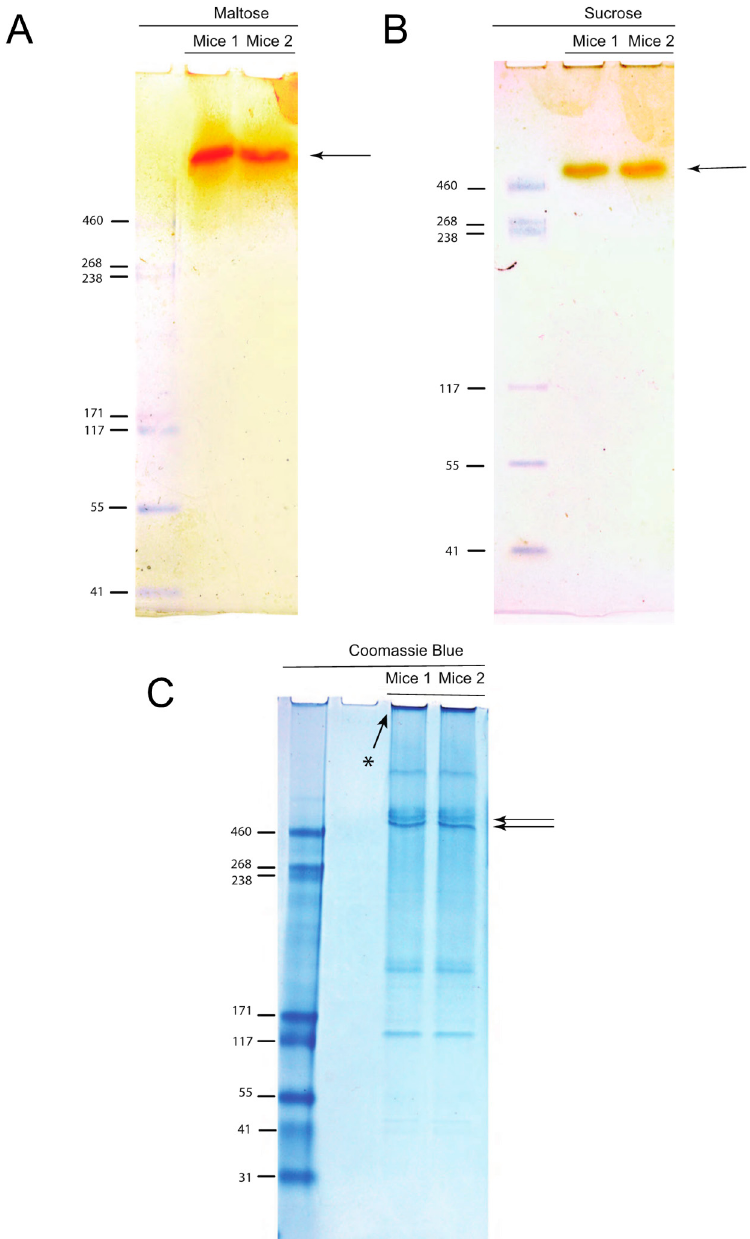
Figure 1. Bands developed indicating α -glucosidase activity by zymography. The polyacrylamide gels were incubated with either maltose ( A ) or sucrose ( B ) solution or Coomassie blue solution ( C ). Then for A and B only, the gel was immersed in assay reagent solution until a well-defined band appeared, as shown. Asterisk (*) on Figure 1C shows proteins that did not run through the